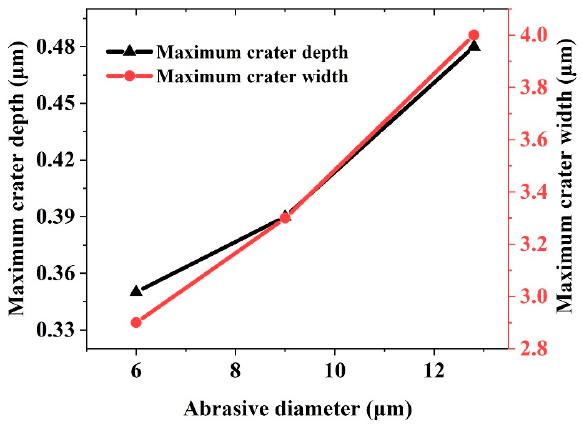
Figure 12. Maximum depth and width of craters under different particle diameters.